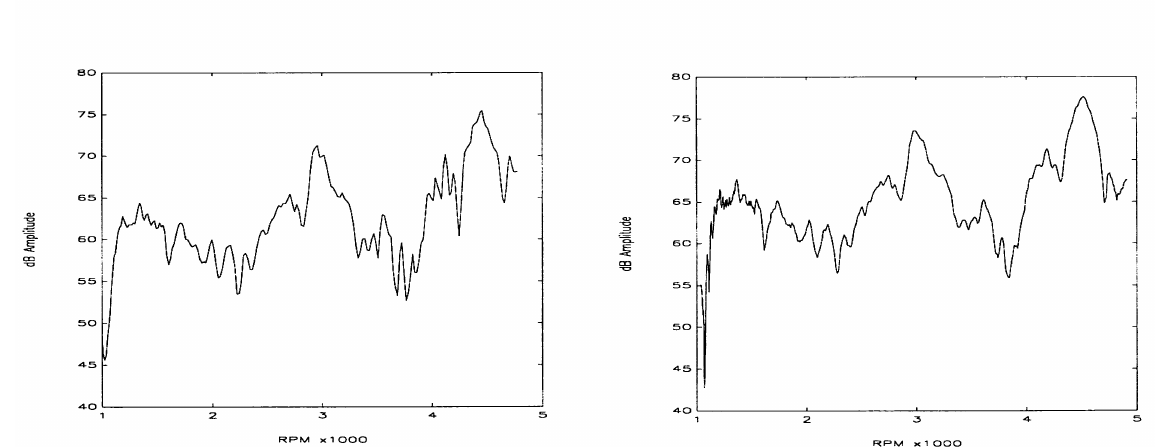
FIGURE 16 Decibel amplitUde of second order (Kal man,